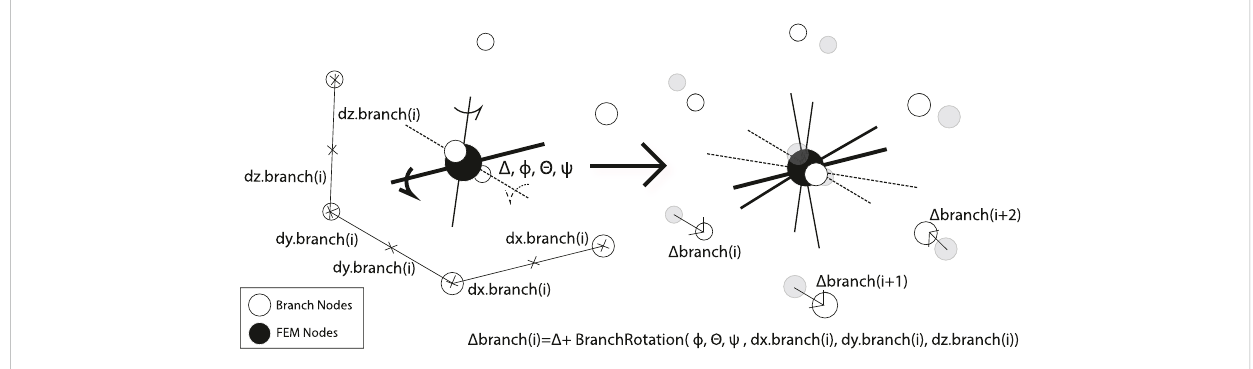
Illustration of rotation of branch nodes completed by FOAMySees.